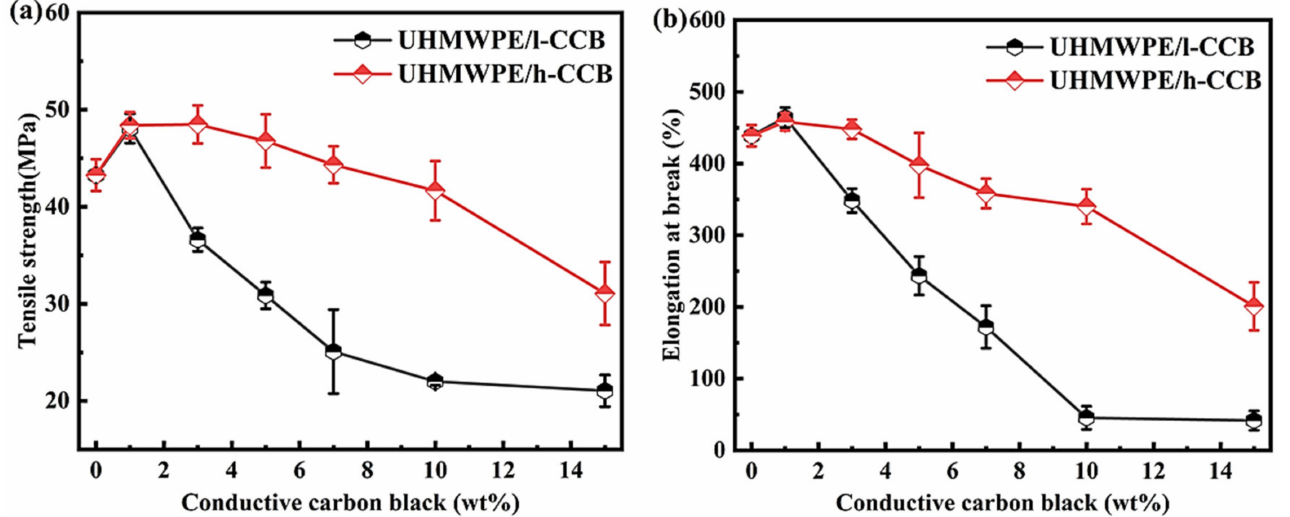
Figure 6. ( a ) tensile strength and ( b ) elongation at break of UHMWPE/CCB